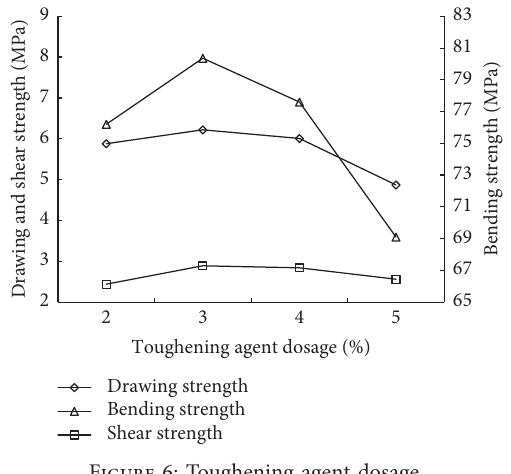
Figure 6: Toughening agent dosage.